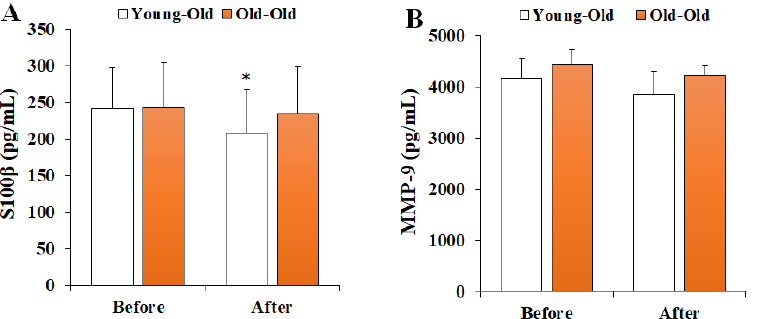
Figure 3. Changes in serum BBB permeability markers. Values presented by mean and standard deviation. ( A ) S100β, S100 calcium-binding protein β; ( B ) MMP-9, matrix metalloproteinases-9; * Significantly different versus Before ( p < 0.05); * Significantly different versus Old-Old group ( p < 0.05).